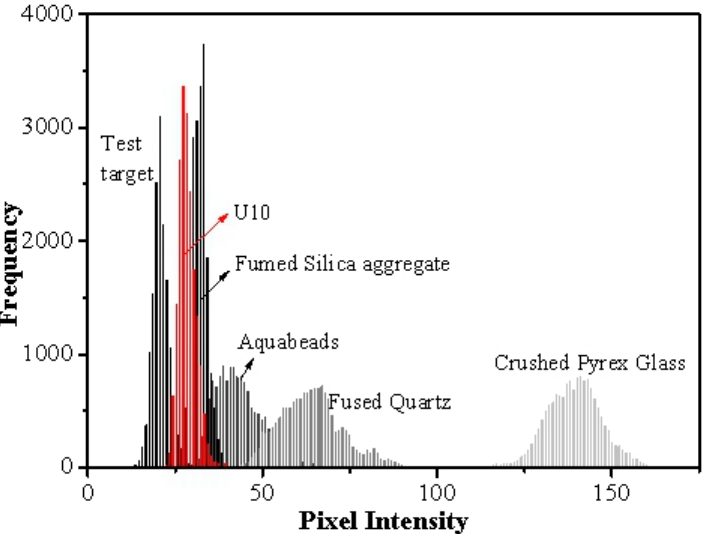
Figure 4. Pixel intensity frequency of the test target in a transparent medium of 50 mm thickness. The thickness of transparent soil has a significant effect on the transparency. Therefore, thicknesses of 50, 100, 150, and 200 mm for a 0.75% mixture of U10 powder were used to calibrate the transparency, The RT values of five different transparent materials versus soil thickness are shown in Figure 5, in which the signs viewed through 50 mm thickness of different transparent materials are shown on the right of the figure. The results indicated that the transparent clay manufactured using U10 has superior transparency compared with other materials and has slightly higher transparency than the fumed silica aggregate, which is a good material used to simulate natural sand. The comparative MTF values versus soil thickness and spatial frequency for the new transparent clay are shown in Figure 6. Targets of 0.02, 0.04, 0.25, and 0.50 lp/mm were used in the transparency calibration. The results indicated that the MTF values of U10 show a linear decrease versus the soil thickness, which means a linear decrease in transparency with an increasing in the sample thickness. The transparency decreased by 17% with each increase of 50 mm measured by the MTF method.